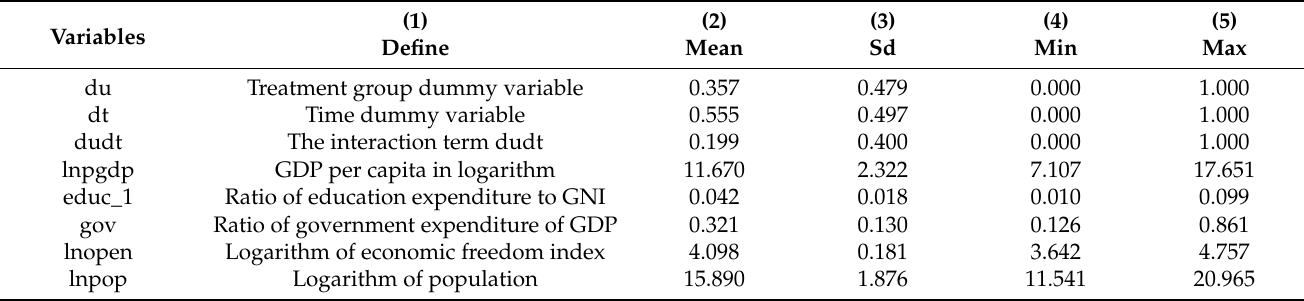
Table 1. Descriptive statistical analysis (N = 1491).